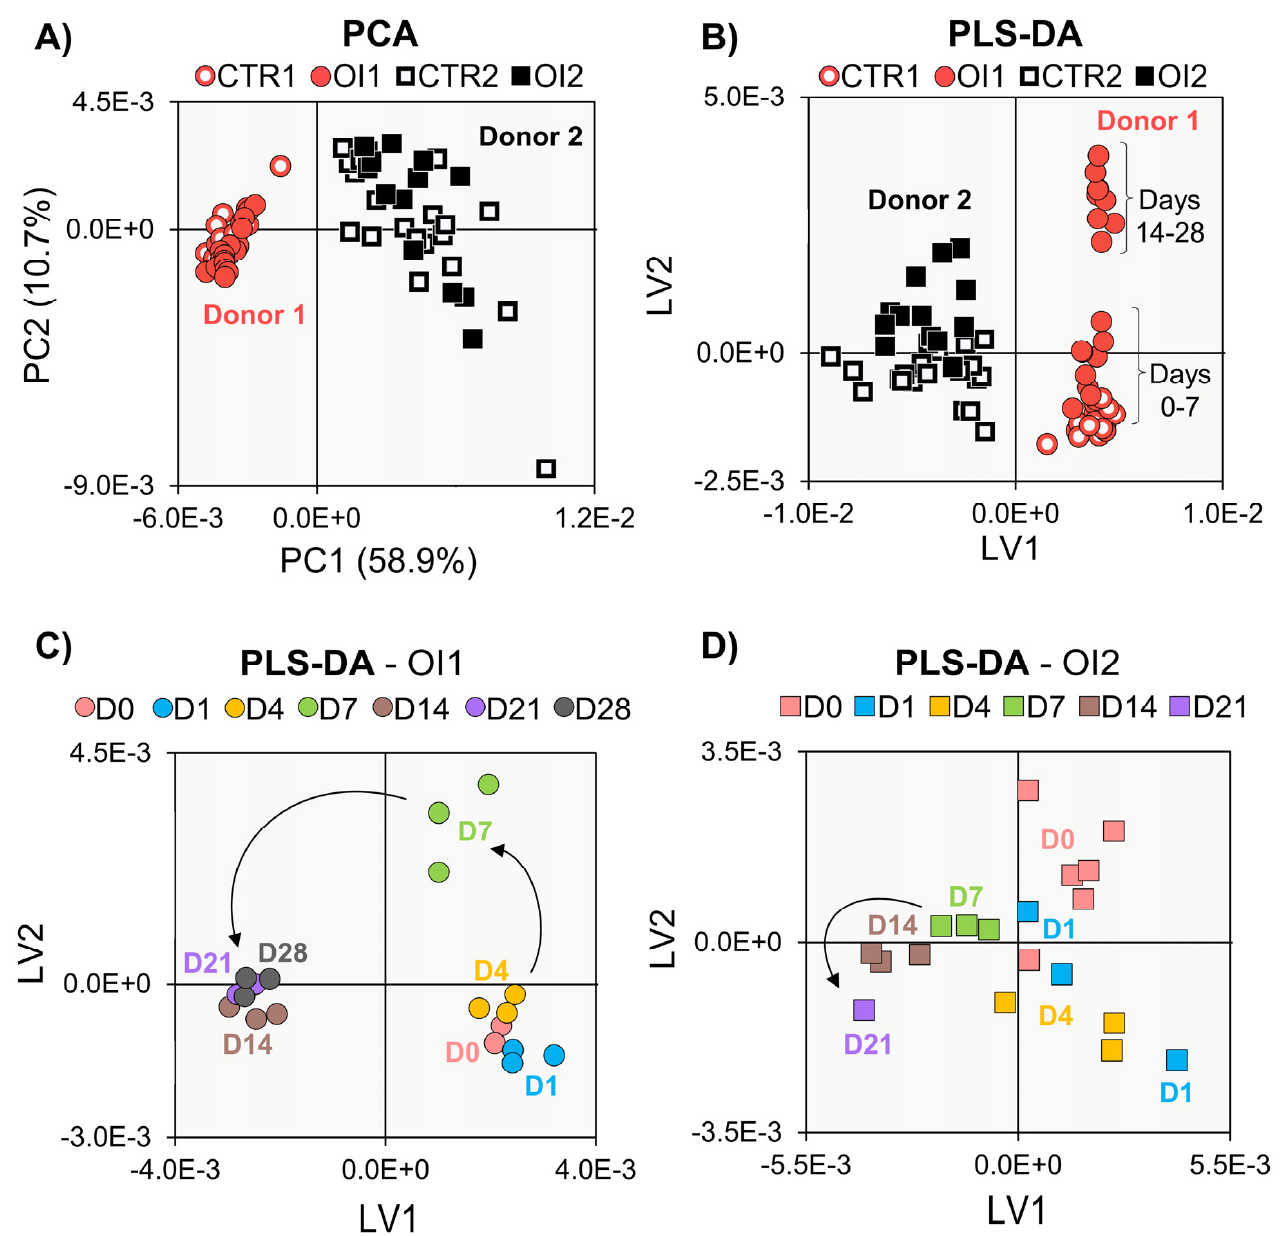
Figure 5. Multivariate analysis of 1 H NMR spectra of polar extracts of osteodifferentiating hAMSCs from different donors. ( A ) PCA of osteodifferentiating hAMSCs (filled symbols) and their control counterparts (open symbols) for donors 1 (red circles) and 2 (black squares). PLS-DA of ( B ) osteodif- ferentiating and control hAMSCs from donors 1 and 2, and individual time course differentiations